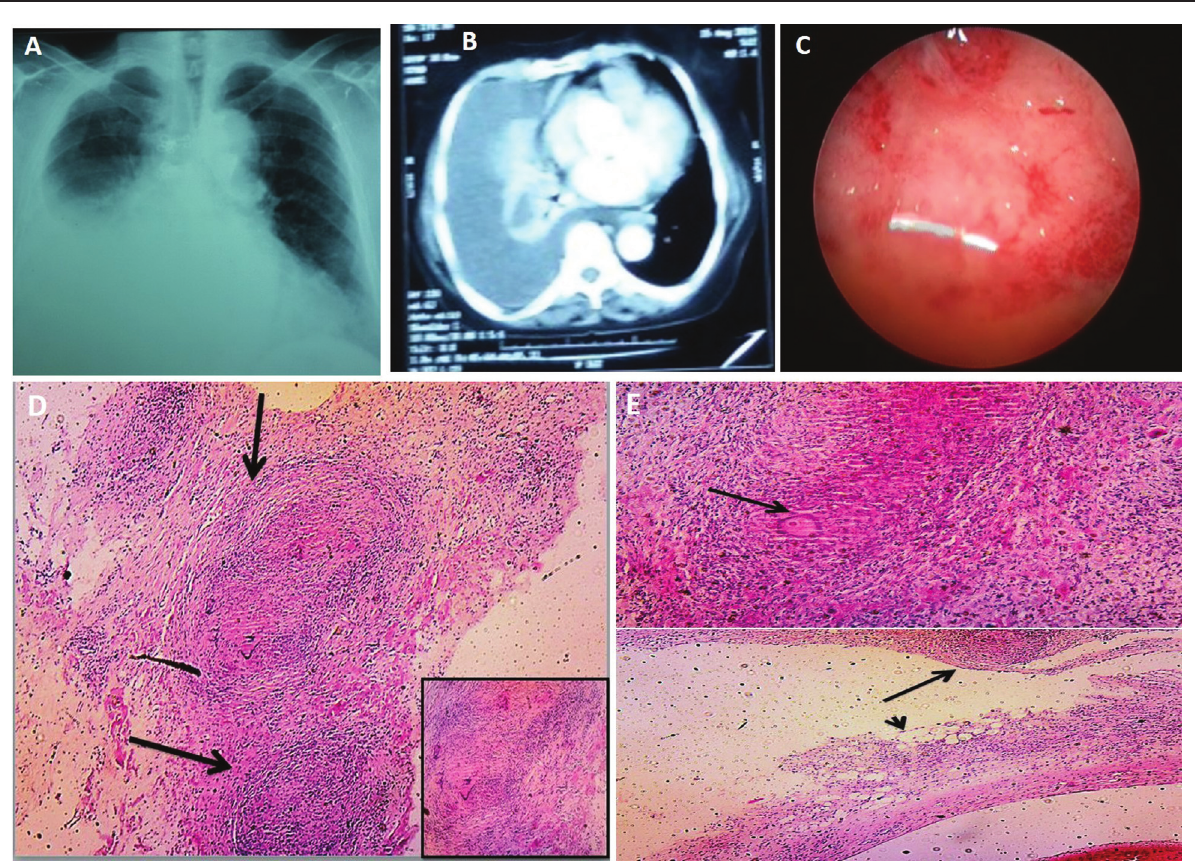
(a) Chest radiography showing moderate right pleural effusion. (b) Axial computed tomography chest mediastinal window with IV contrast showing right pleural effusion. (c) Thoracoscopic image showing diffuse thickening and inflammation of the costal pleura. (d) Rigid forceps biopsy histopathology image showing multiple caseating granulomas (black arrows) consistent with tuberculosis. (e) Cryoprobe biopsy histopathology image showing caseating granuloma with Langhans giant cells (black arrows) and good biopsy depth was evident by the presence of vacuolated fat cells (black arrow head).